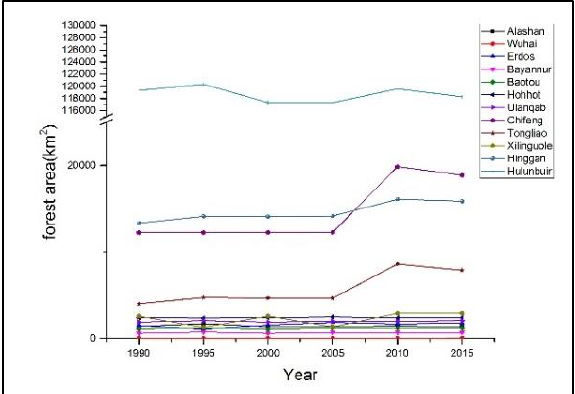
Figure 4. Forest cover change of different cities in Inner Mongolia